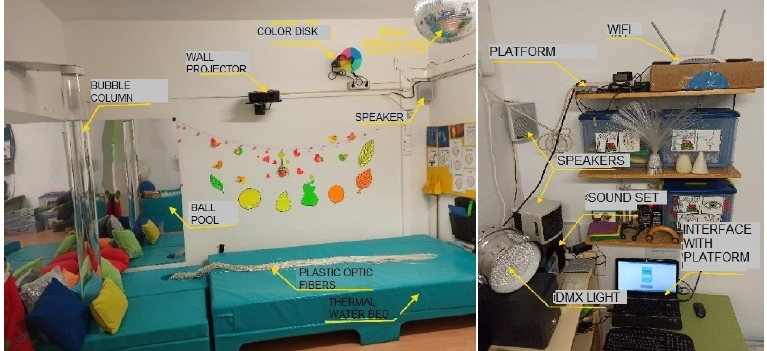
Figure 22. Preceding system of context anticipation: Alborada’s sensory stimulation room.